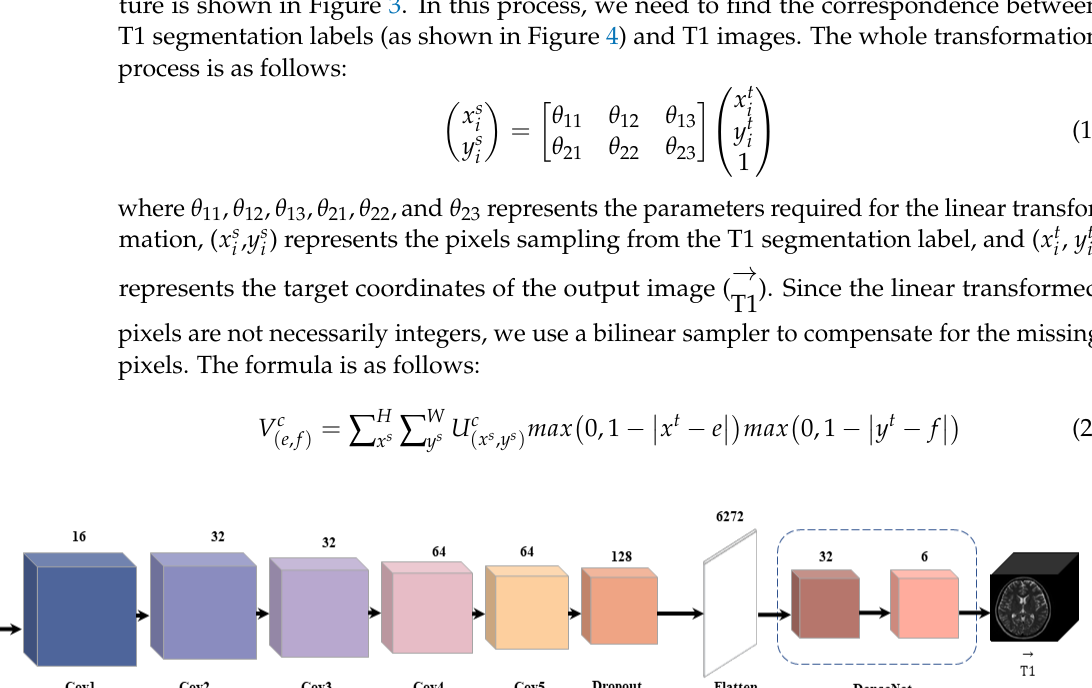
Figure 2. Process figure of the ROI border enhancement network. We have condensed the whole process into two figures. The figure ( a ) represents the correspondence between finding the T1 segmentation label and the T1 image. In this process it is assumed that the output pixels are defined on a regular network so that a mapping relationship between the input and output can be constituted. Finally, we can zero-fill the missing ROI boundaries. The red points in figure ( b ) represent the original contour points and the green points represent the fill points.